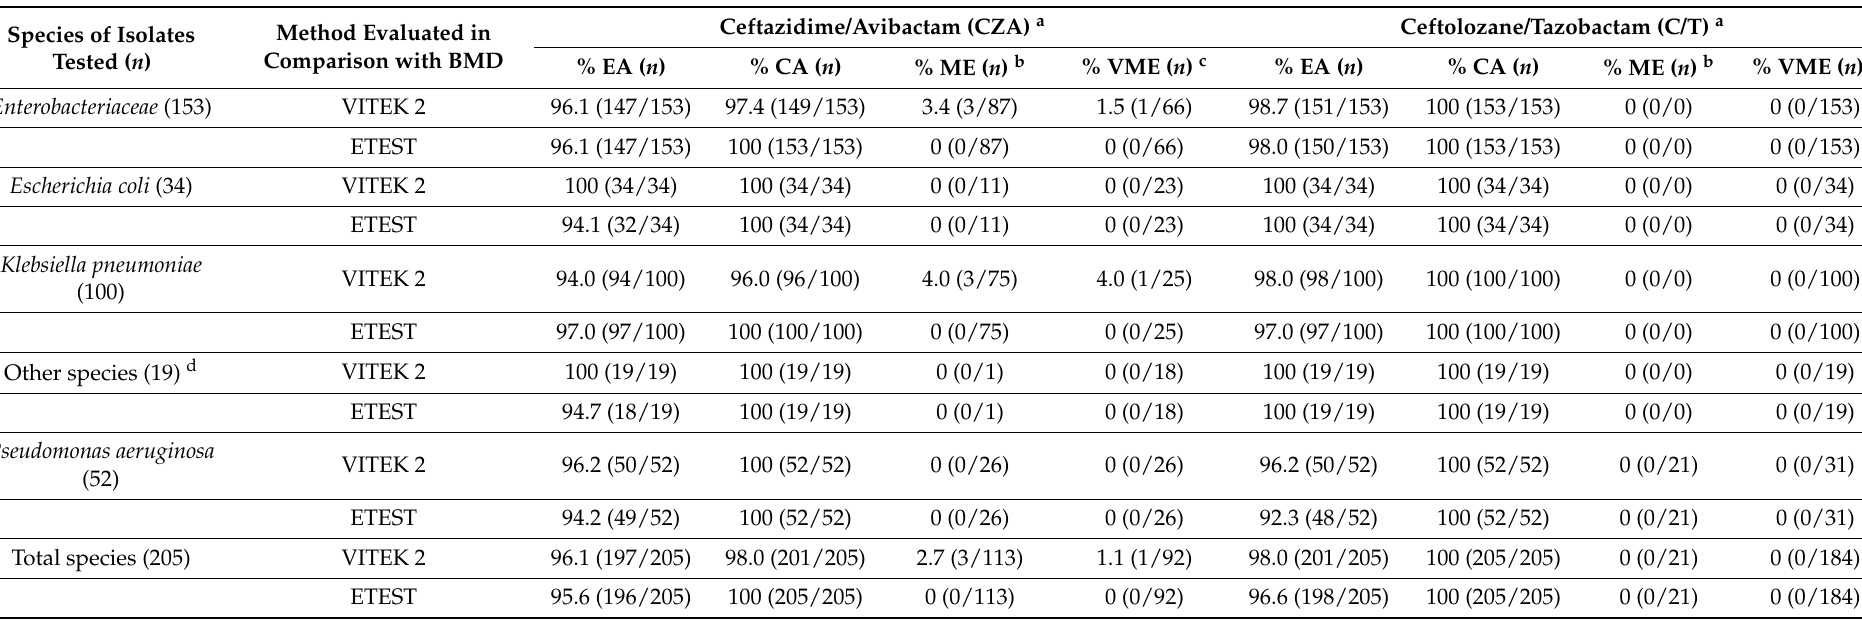
Table 2. Agreement and error rates in testing 205 Gram-negative bacterial isolates against ceftazidime/avibactam and